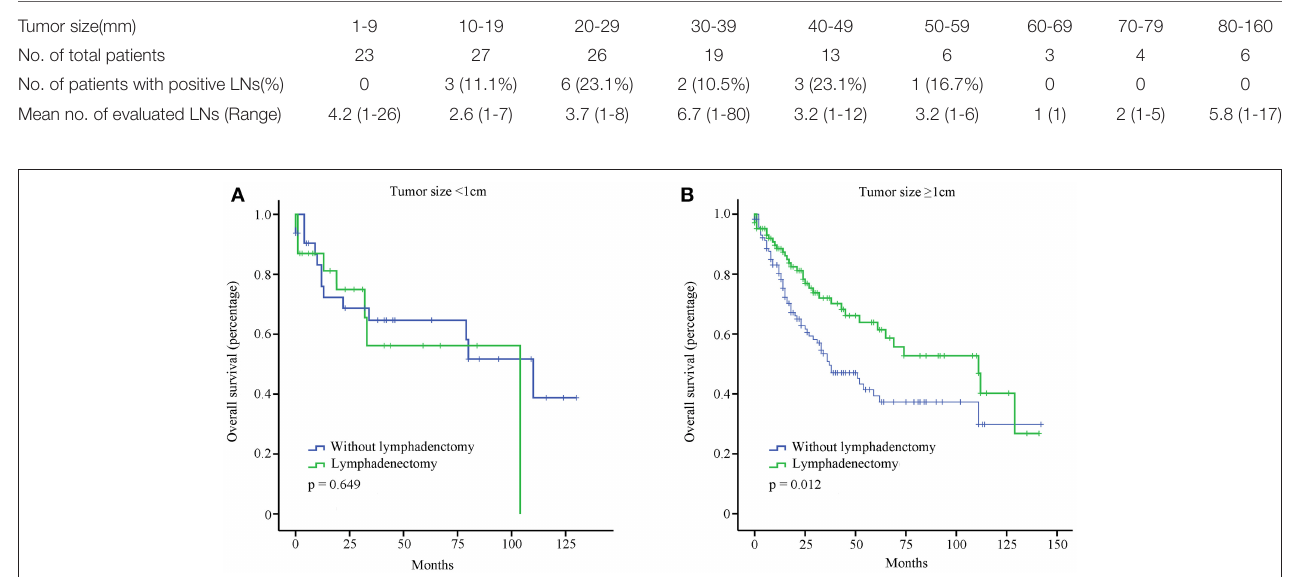
Frontiers in Oncology |